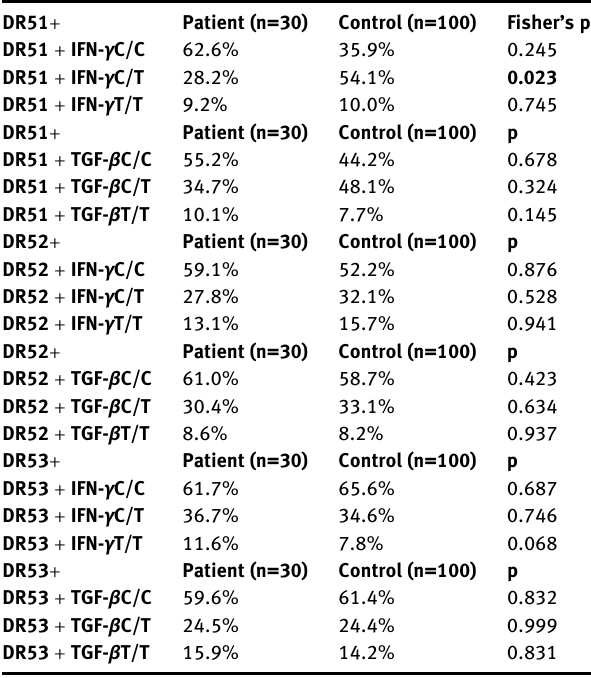
Table  : HLA-DR supertype antigens of the patients, and the asso- ciation with TGF- β , IFN- γ